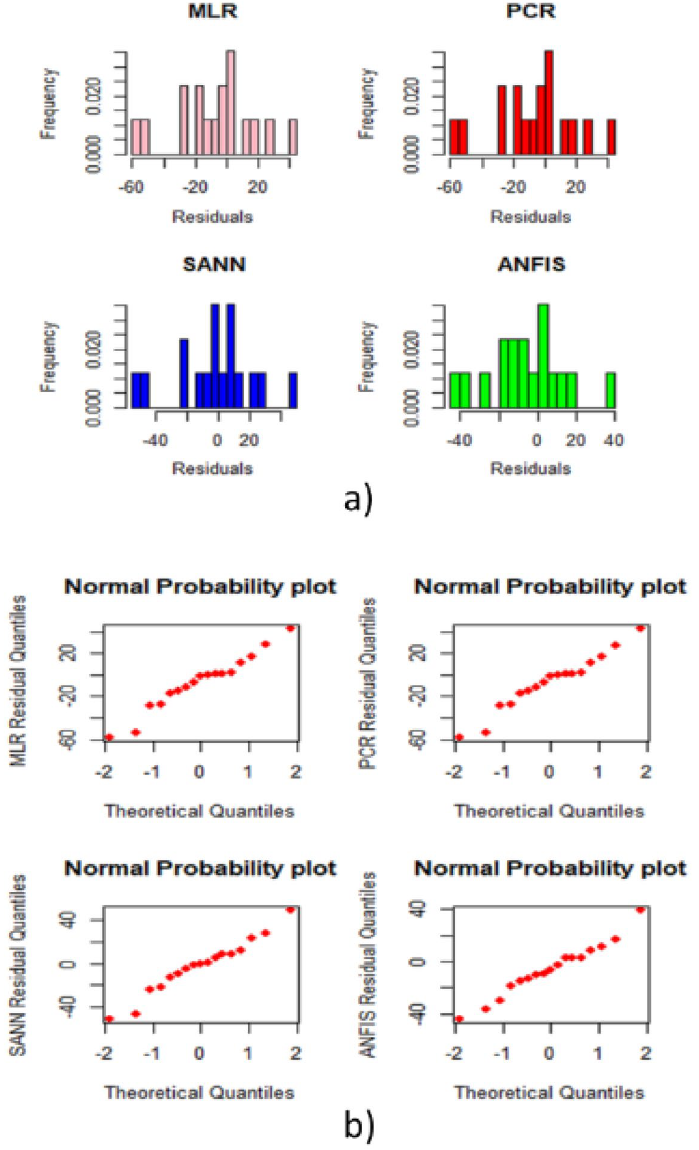
Figure 12. ( a ) Residual histograms, ( b ) residual